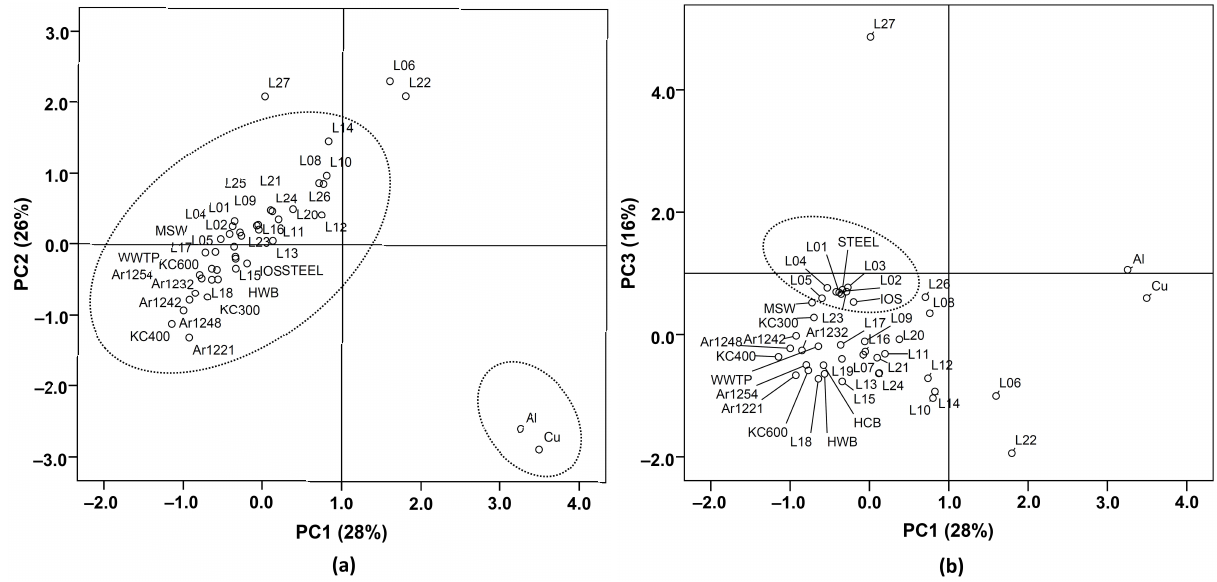
Figure 5. PCA score plot of the dioxin-like PCB (dl-PCB) congeners in the sediments of LSR